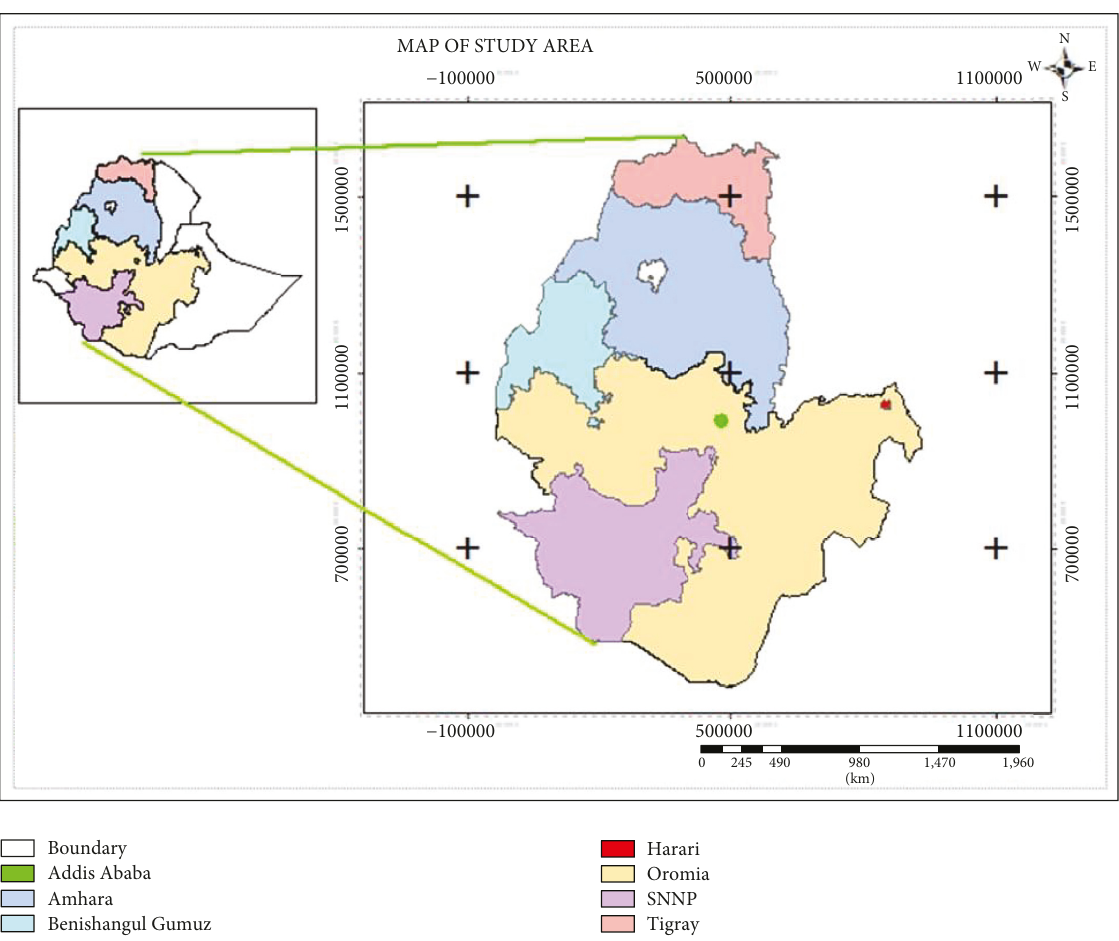
Figure 3: Regions from where the reports were